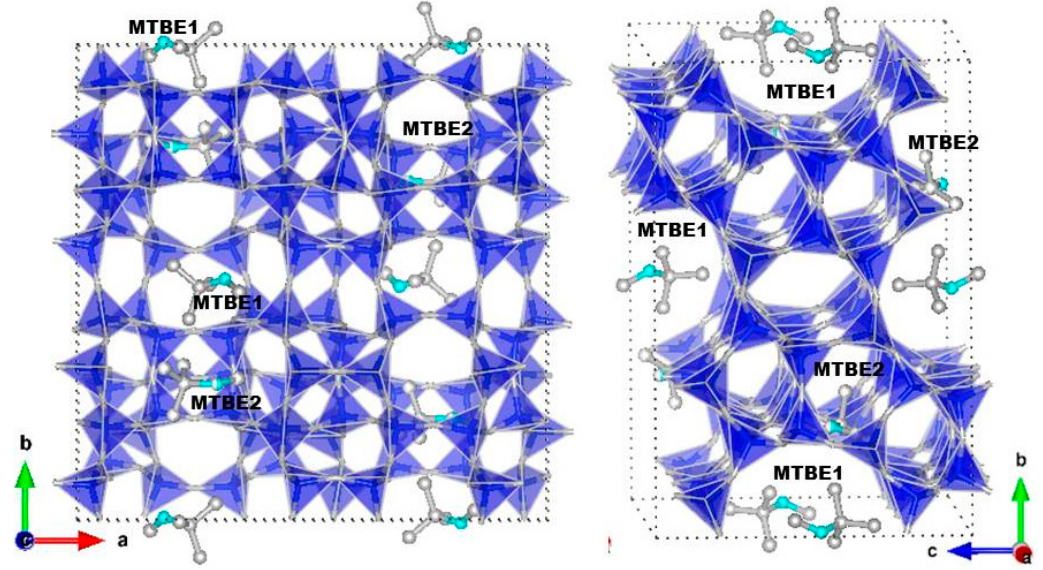
Figure 1. High-loaded structure of ZSM-5-methyl- tert -buthyl-ether (MTBE) along a and c directions, respectively. Water molecules are represented as light blue spheres.